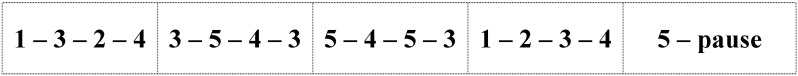
Note sequence played by the left hand.5 (C3) = pinky and 1 (G3) = thumb.